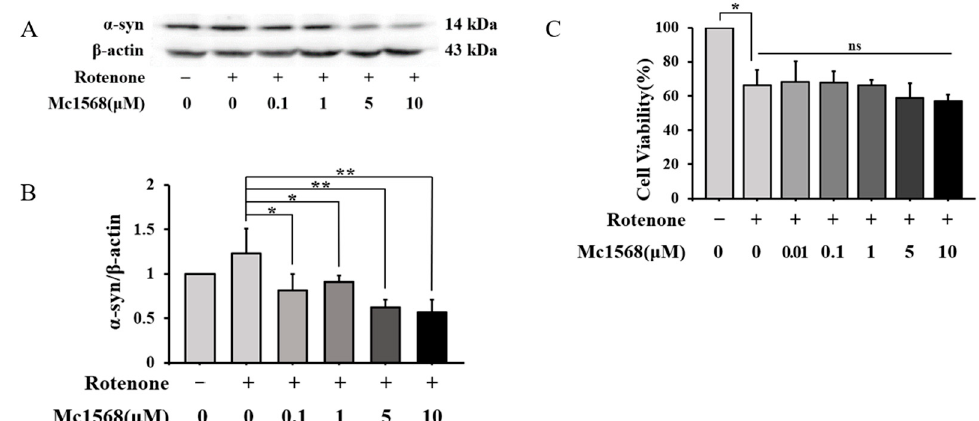
Figure 2. Mc1568 induced a decrease in α -syn levels in rotenone-treated SH-SY5Y cells without impairment of cell viabilities. SH-SY5Y cells were treated with indicated concentrations of mc1568 for 2 h. Then, 1 µM of rotenone or vehicle was added to the medium for another 24 h. α -Syn levels were detected through Western blot analysis. Cell viability was detected through CCK-8. ( A , B ) Mc1568 decreased α -syn levels in SH-SY5Y cells with the treatment of rotenone in a concentration-dependent manner. ( C ) Mc1568 had no significant influence on rotenone-treated SH-SY5Y cells. * p < 0.05; ** p < 0.01; ns., non-significant.